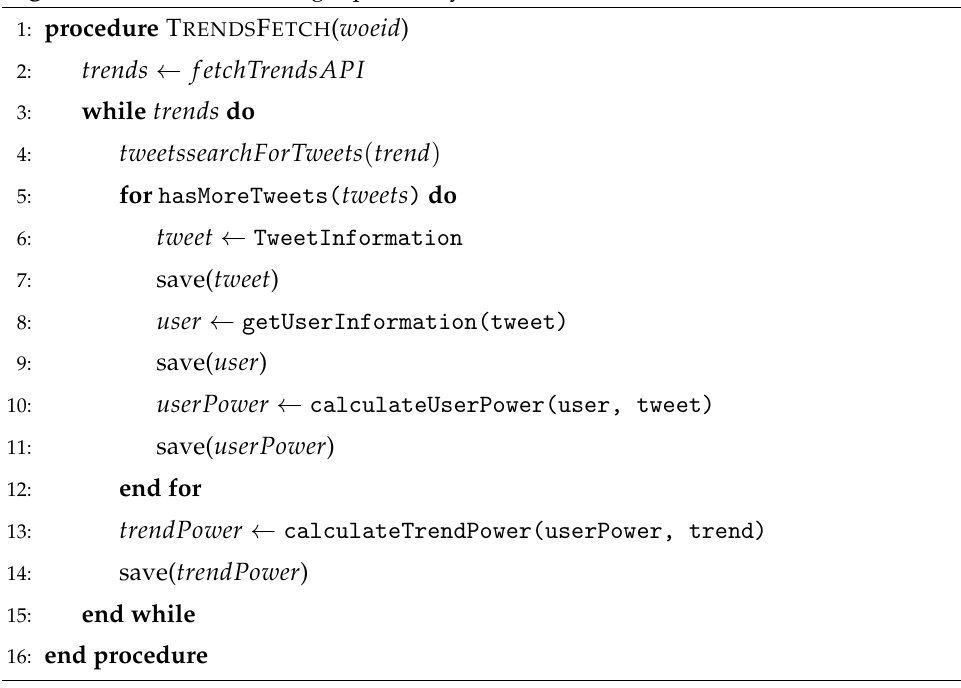
Algorithm 1 Twitter trending topics